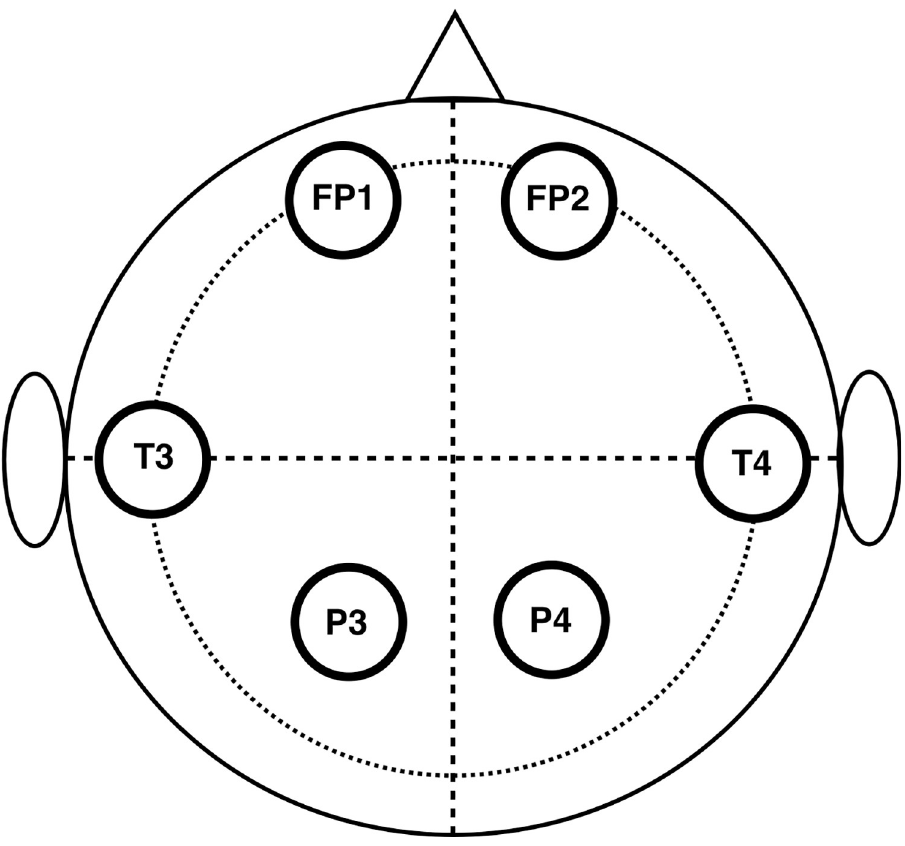
Fig 1. The position of electroencephalography signals recording, using 10–20 systems. FP1 & FP2, fronto-parietal electrode 1 & 2; T3 & T4, temporal electrode 3 & 4; P3 & P4, parietal electrode 3 & 4.